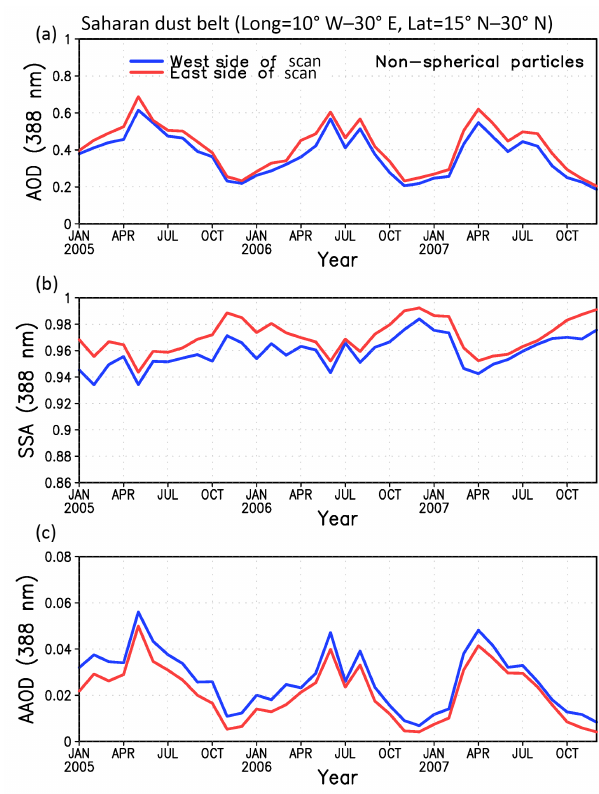
Figure 8. Time series of calculated monthly average UV-AI over the Northeast US (a) , SAF (b) , and SAH (c) regions using rows 1 to 30 (blue) and 31 to 60 (red).